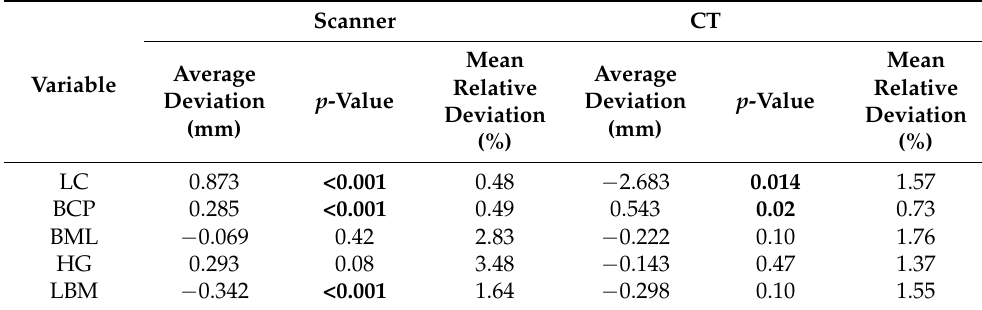
Table 4. Results of statistical testing of measurement deviations using both methods from primary measurements for all (60 samples) selected mandible variables.